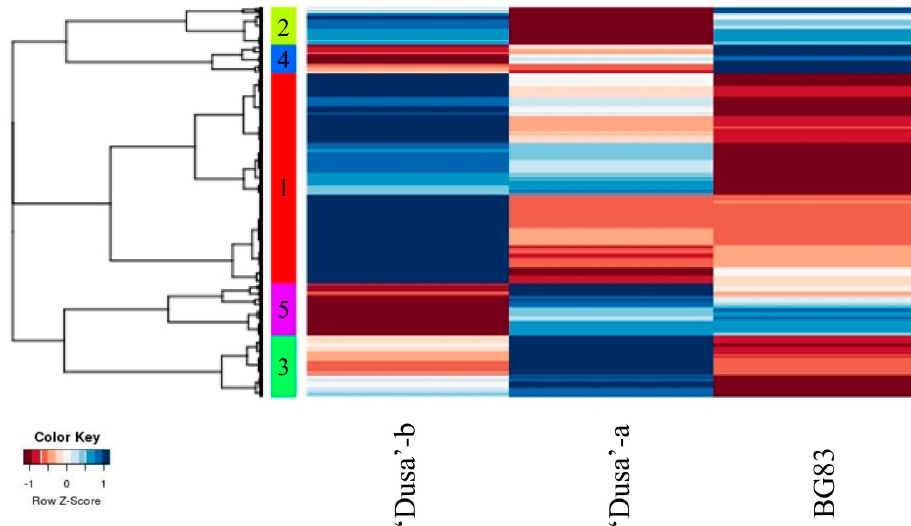
Fig 4. Hierarchical clustering (HCL) of differentially expressed genes (DEGs). HCL of DEGs in at least one of the samples of ‘Dusa’-b, ‘Dusa’-a and tolerant BG83 avocado rootstocks after infection with R . necatrix , clustered by hclust according to their expression profiles (Pearson’s values correlation analysis). The five colours on the left correspond to the five groups with different expression profiles.